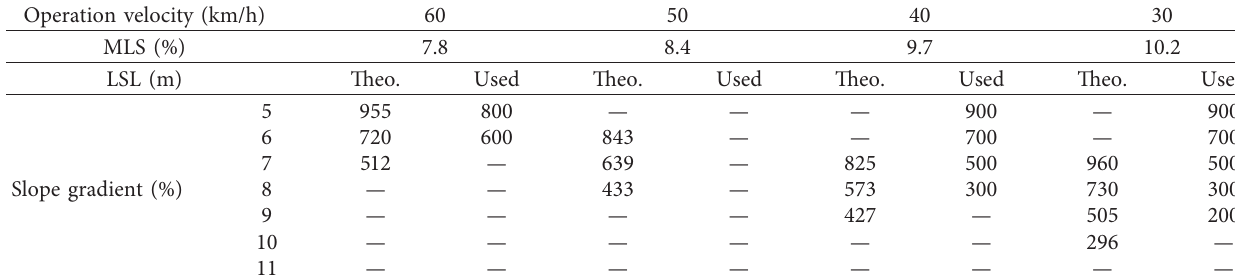
Table 3: The theoretical values of LSLs.